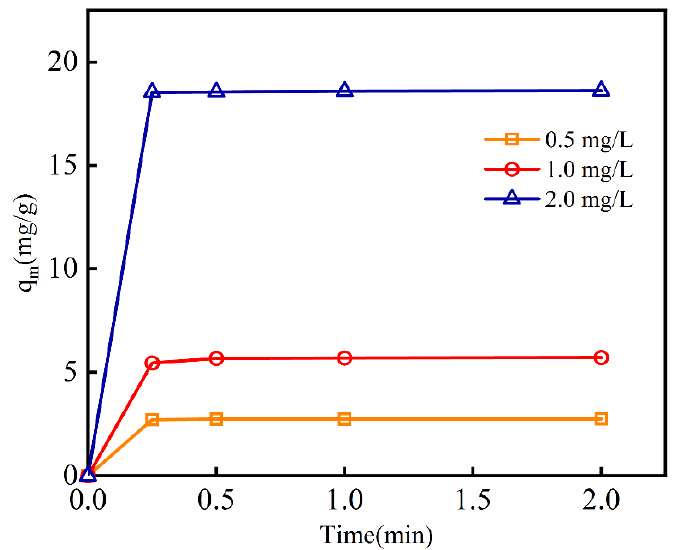
Figure 5. Adsorption capacity of carbon black to TCS at different initial concentrations.